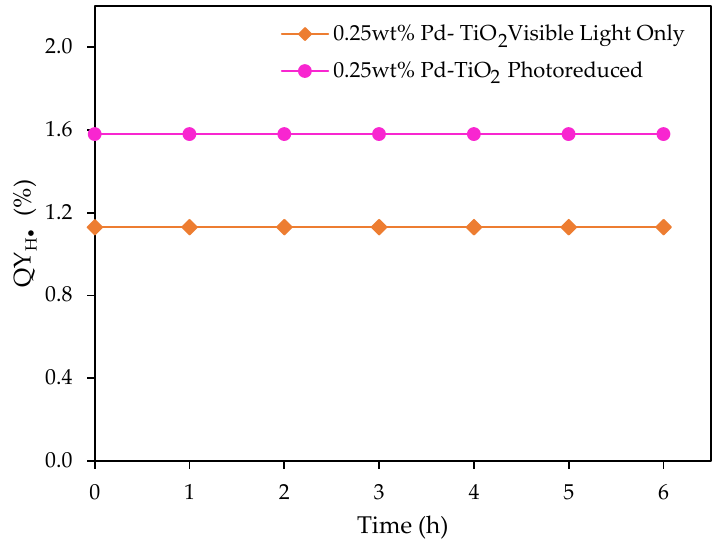
Figure 14. 𝑄𝑌 𝐻 • % for the 0.25 wt% Pd-TiO 2 photocatalyst, at 0.15 g L −1 photocatalyst concentration, and various visible light irradiation times. Initial pH = 4 ± 0.05 and 2.0 v / v % ethanol. Note: the pho- tocatalyst reported with the pink line was photoreduced for 1 h under near-UV light, followed by 5 h of visible light irradiation. Figure 15 and Table 5 report the QY H • % obtained for the 24 h of near-UV photoreduc- tion, followed by 5 h of visible light irradiation. The selected conditions for the reaction remained unchanged, as in previous experimental runs: (a) 2.0 v / v % ethanol; (b) initial pH = 4 ± 0.05; and (c) 0.15 g L − 1 of TiO 2 .